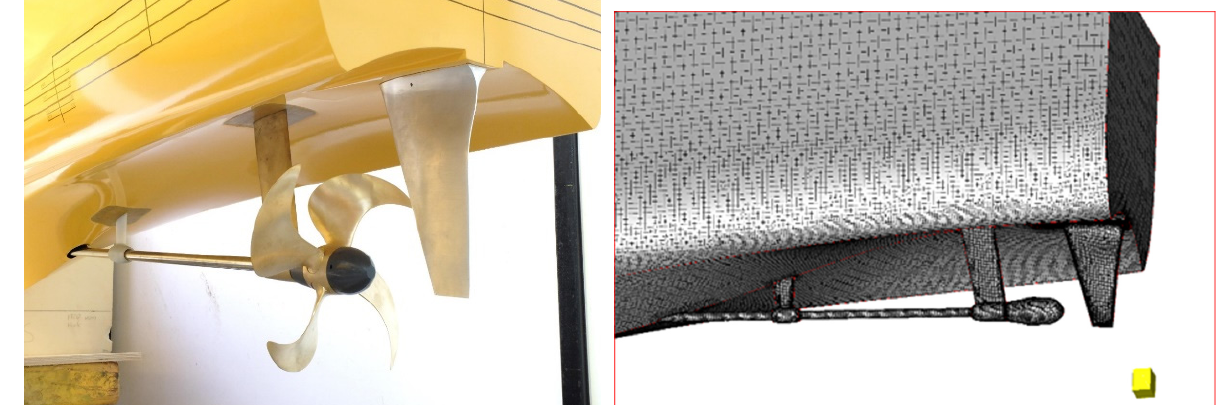
Figure 13. Numerical mesh around the stern tunnel area for the local optimization by FreSCo+ of the Stavanger Demonstrator (5.7M)—H2020 TrAM Project Battery driven fast Catamaran Local Op- timization of Transom Stern [21].